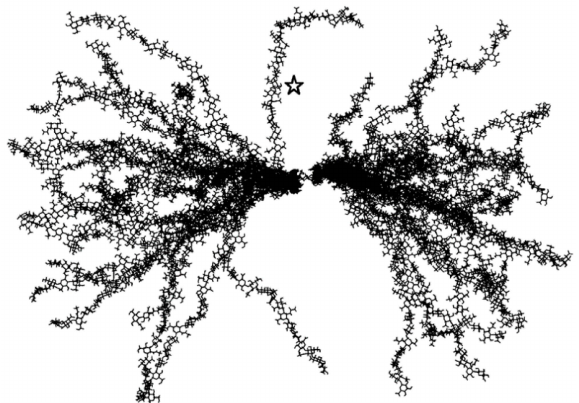
Figure 2. Conformational ensemble of hyaluronan 50-mers created by extrapolating from glycosidic linkage conformations sampled in molecular dynamics simulations of hyaluronan oligosaccharides. The star indicates a continuous linear stretch in one of the 50-mers. Reprinted with permission from Ref. [55]. Copyright 2006